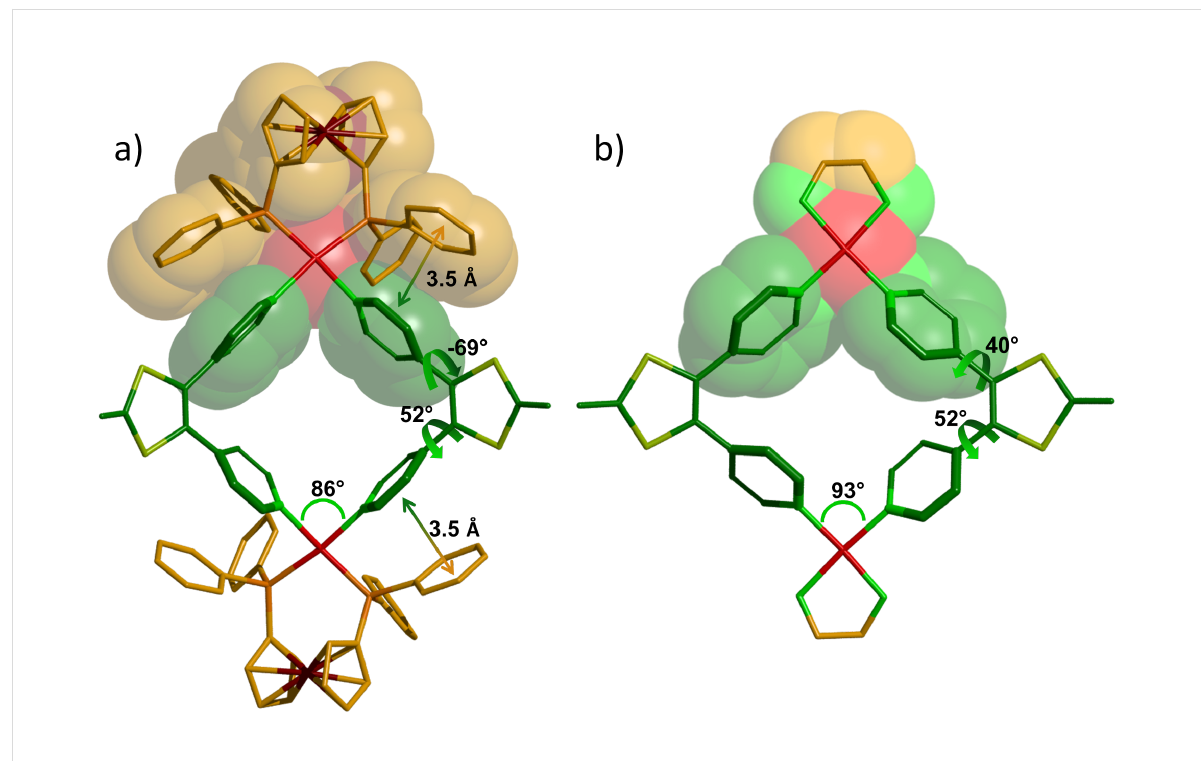
Figure 4: Geometry (from XRD) around two Pd centers in M 4 L 2 (a) and M 6 L 3 (b). The exTTF moieties have been cut for clarity.